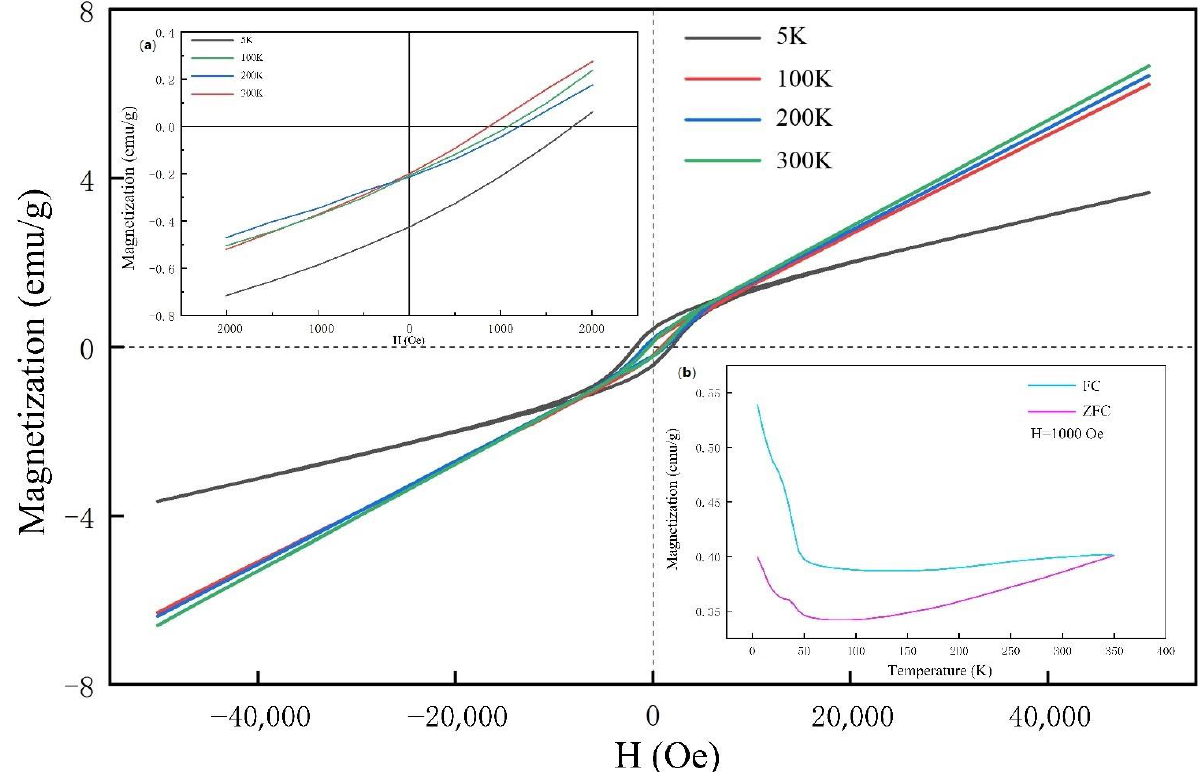
Figure 6. Hysteresis loops for Mn 2 N 0.86 at 5 K, 100 K, 200 K, and 300 K. ( a ) The M-H curves within the magnetic field of 2000 Oe. ( b ) The temperature dependences of the magnetization for the Mn 2 N 0.86 ; the applied magnetic field is 1000 Oe.